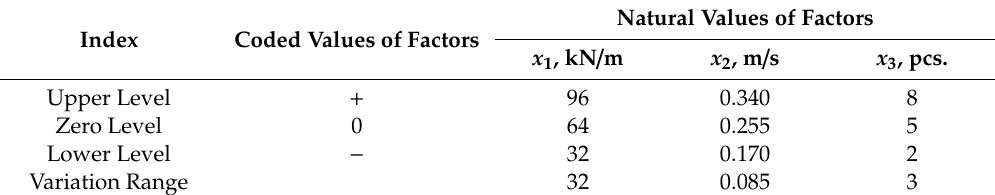
Table 4. Levels and ranges of factor variation in the